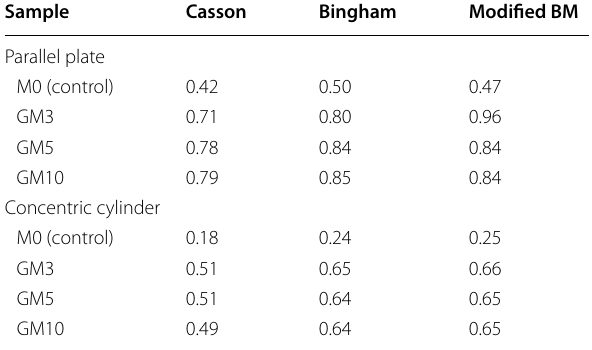
Table 11 Influence of shear rate range on plastic